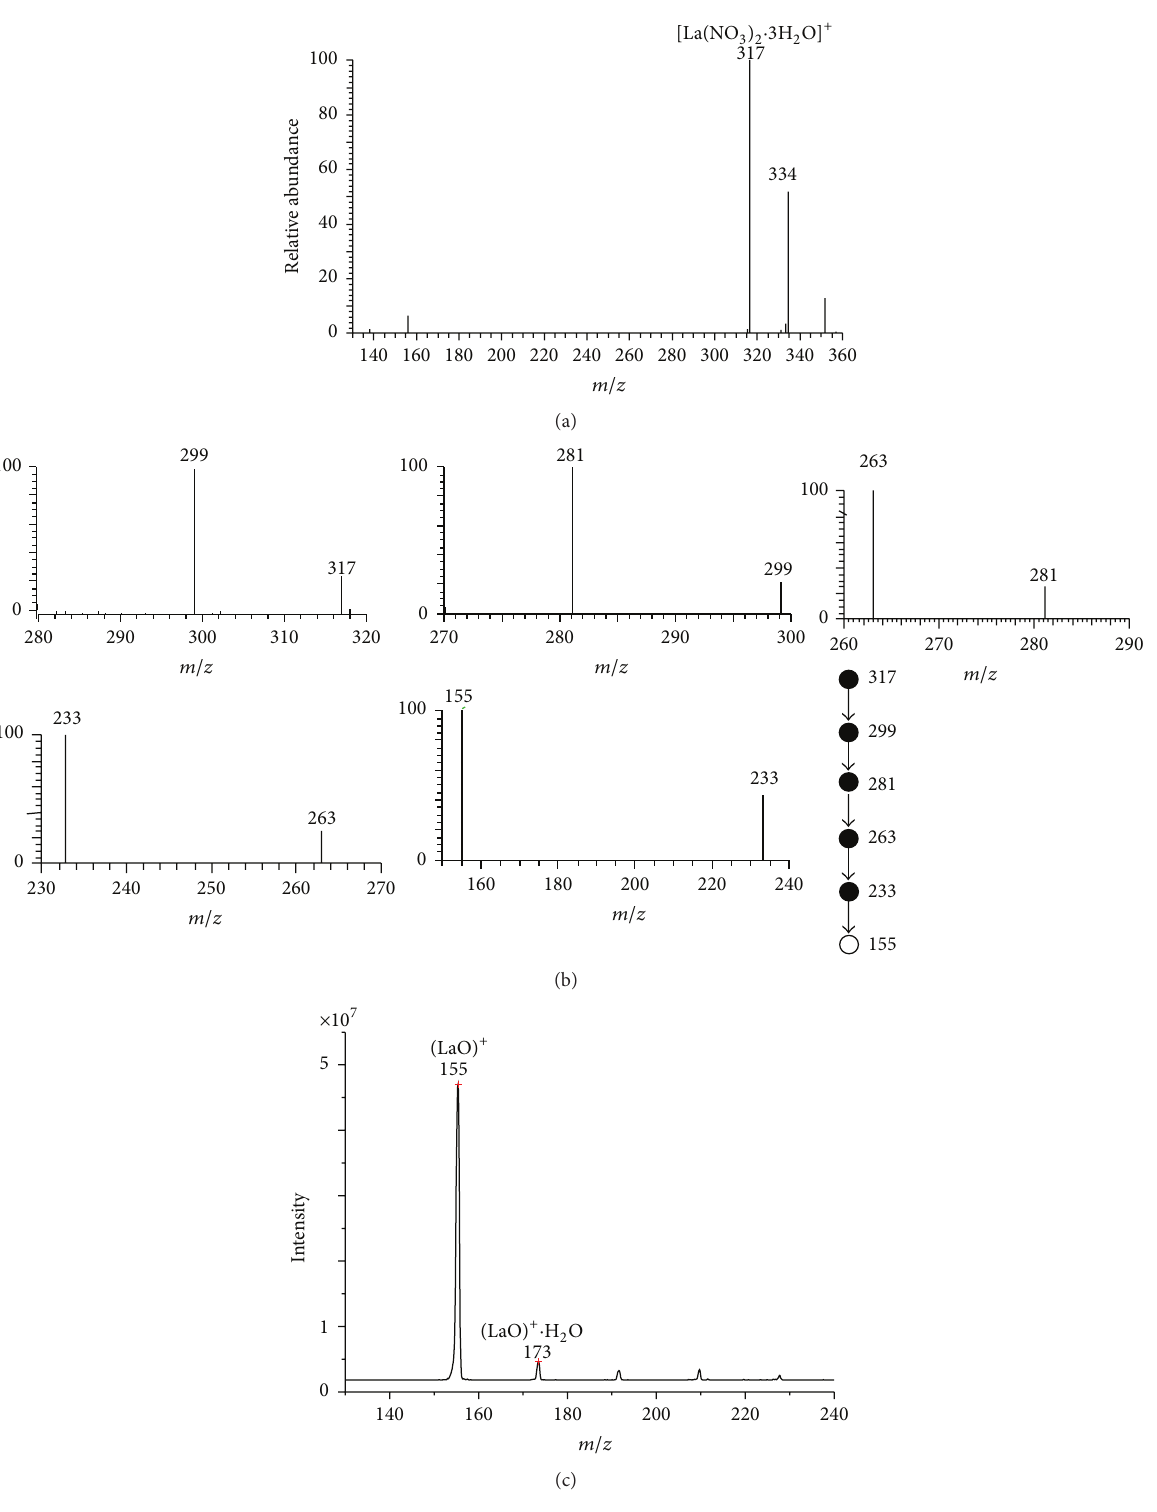
Figure 2: (a) The MPT mass spectrum of lanthanum collected on the MPT-LTQ-MS in positive mode. A 10mg/L lanthanum standard solution was used. (b) MS 𝑛 mass spectra of the precursor ions 𝑚/𝑧 317, 𝑛 up to 6. The subprecursor ions series are 317 → 299 → 281 → 263 → 233 → 155 , corresponding to the dissociation fragment series H 2 O, H 2 O, H 2 O, NO, and NO 4 . (c) The MPT mass spectrum of La collected on a MPT quadrupole mass filer mass